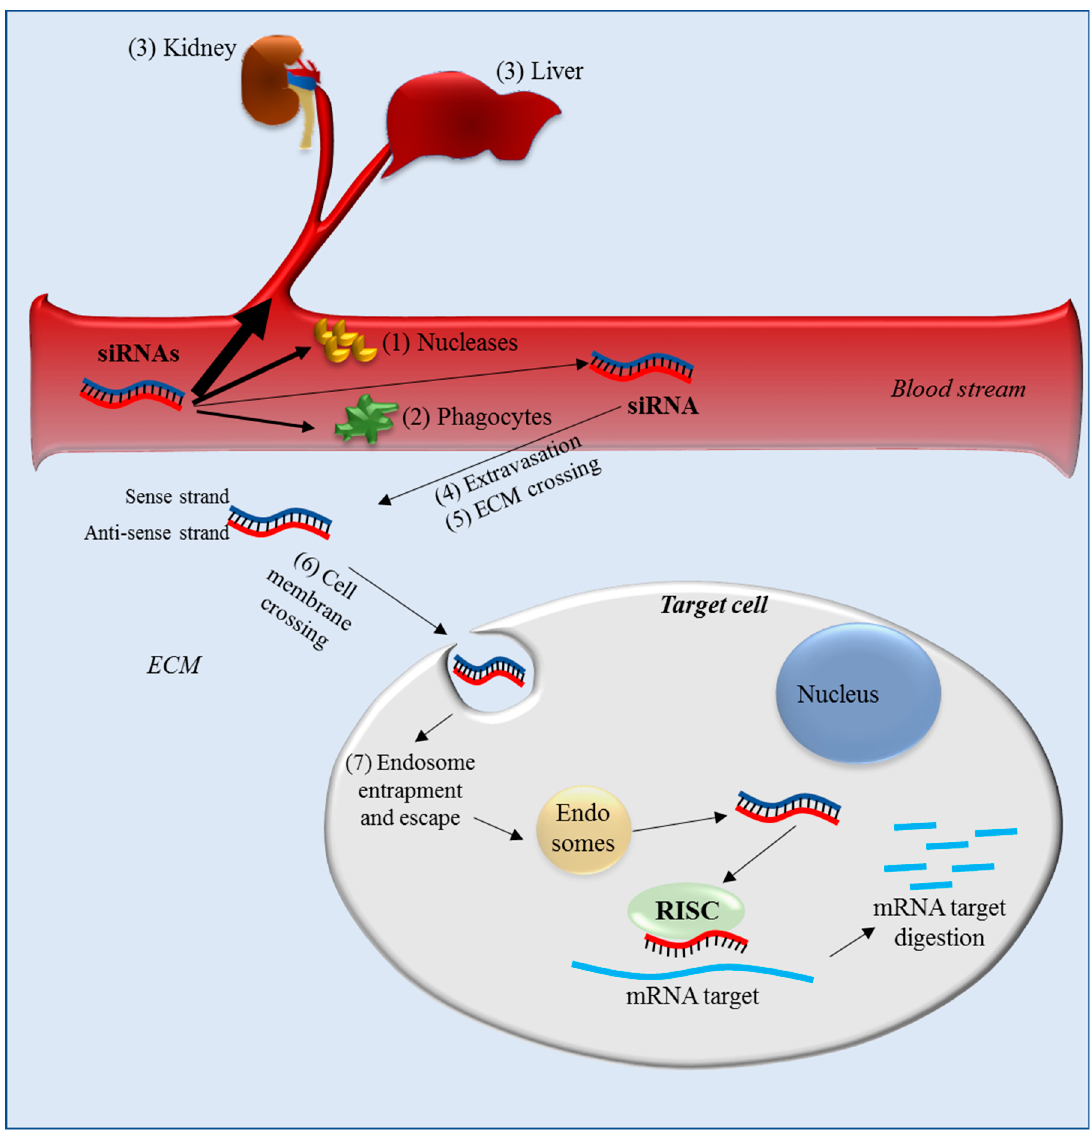
Figure 4. Obstacles for systemic siRNA delivery.